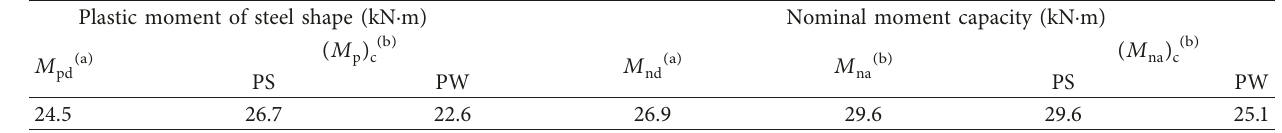
Table 4: Moment capacity of the section.